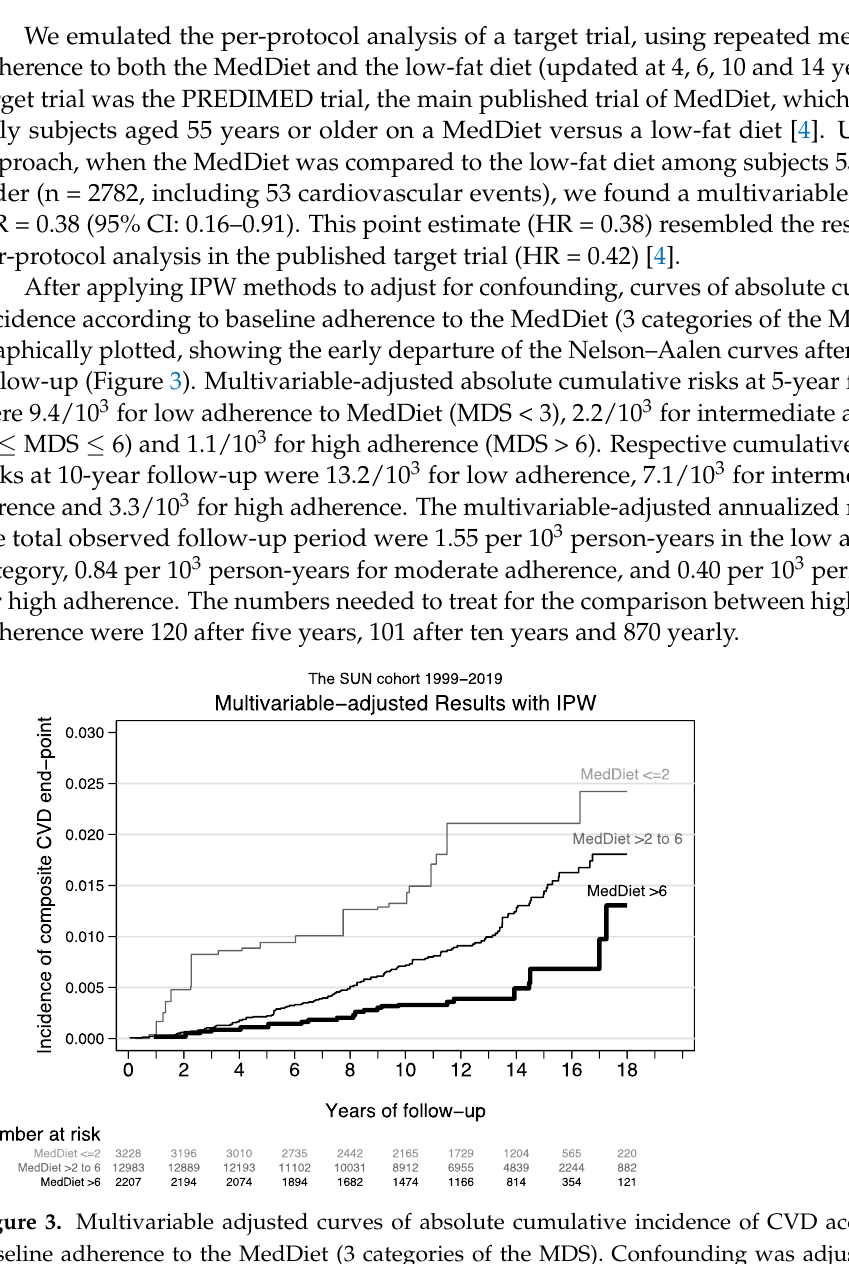
Table 5. Negative controls: HR (95% confidence intervals) for every 2 additional points in the base- line MDS in the “ Seguimiento Universidad de Navarra ” (SUN) cohort, 1999 – 2019. Multivar-adj. HR (95% CI)